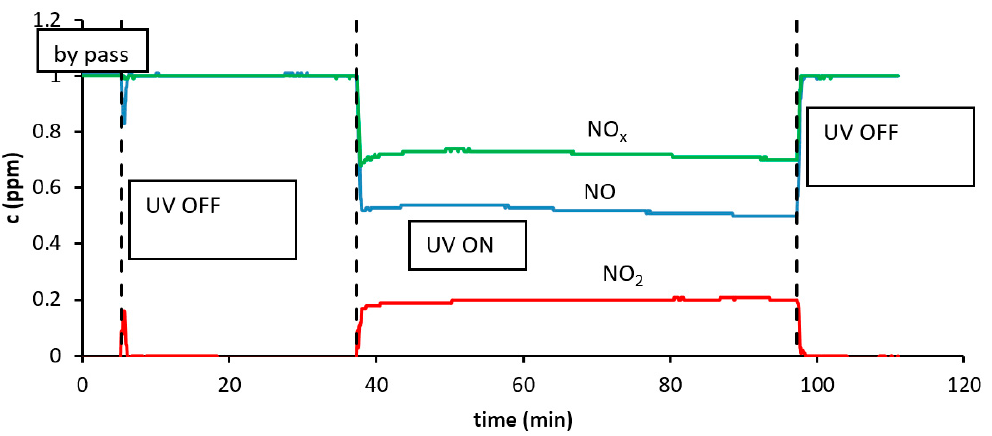
Figure 5. Removal of NO x on a film of Ex-CN (0.5 mg / cm 2 ).